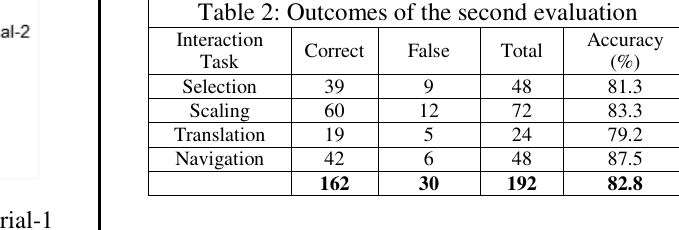
Table 2: Outcomes of the second